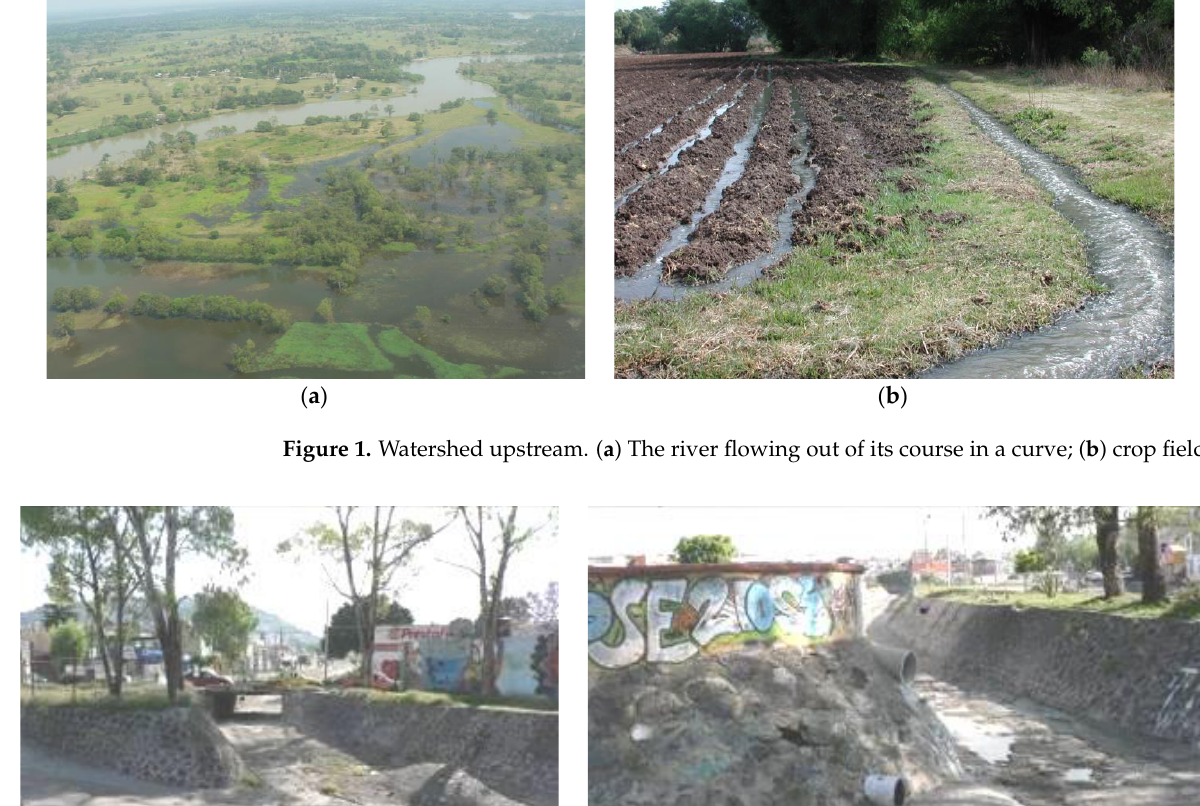
Figure 2. Urban drainage elements. ( a ) Confluence of channels; ( b ) drainage pipes into the channel.